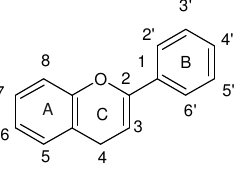
Figure 1 . General structure of